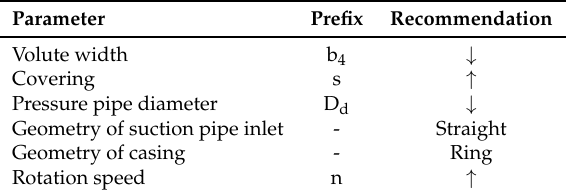
Table 6. Design recommendations for the casing and rotational speeds of a vortex